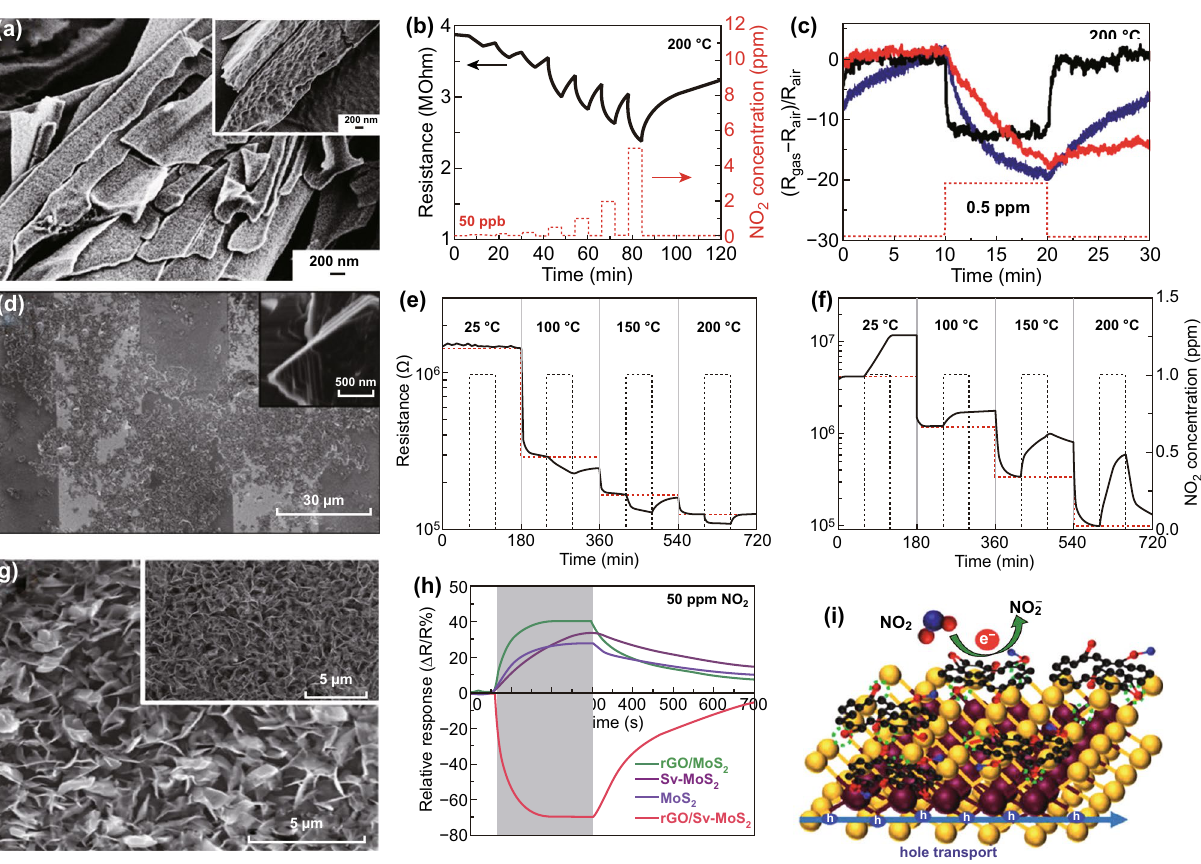
Fig. 15 a FESEM image of 3D MoS 2 aerogels. b Response of MoS 2 aerogel with NO 2 at 200 °C. c Device response to NO 2 at different tem- peratures. Reproduced with permission from Ref. [24]. Copyright (2017) Wiley-VCH. d FESEM image of MoS 2 flakes distributed on the Pt electrodes. NO 2 response of the MoS 2 flakes: e annealed at 150 °C showed p-type behavior; f annealed at 250 °C showed n-type behavior. Reproduced with permission from Ref. [31]. Copyright (2015) Elsevier. g FESEM image of sulfur vacancy-enriched MoS 2 flakes. h Response of 50 ppm NO 2 with MoS 2 , rGO/MoS 2 , Sv-MoS 2 , rGO/Sv-MoS 2 . rGO deposited Sv-MoS 2 shown p-type behavior. i Mechanism of NO 2 interaction with rGO deposited Sv-MoS 2 . Reproduced with permission from Ref. [310]. Copyright (2019)